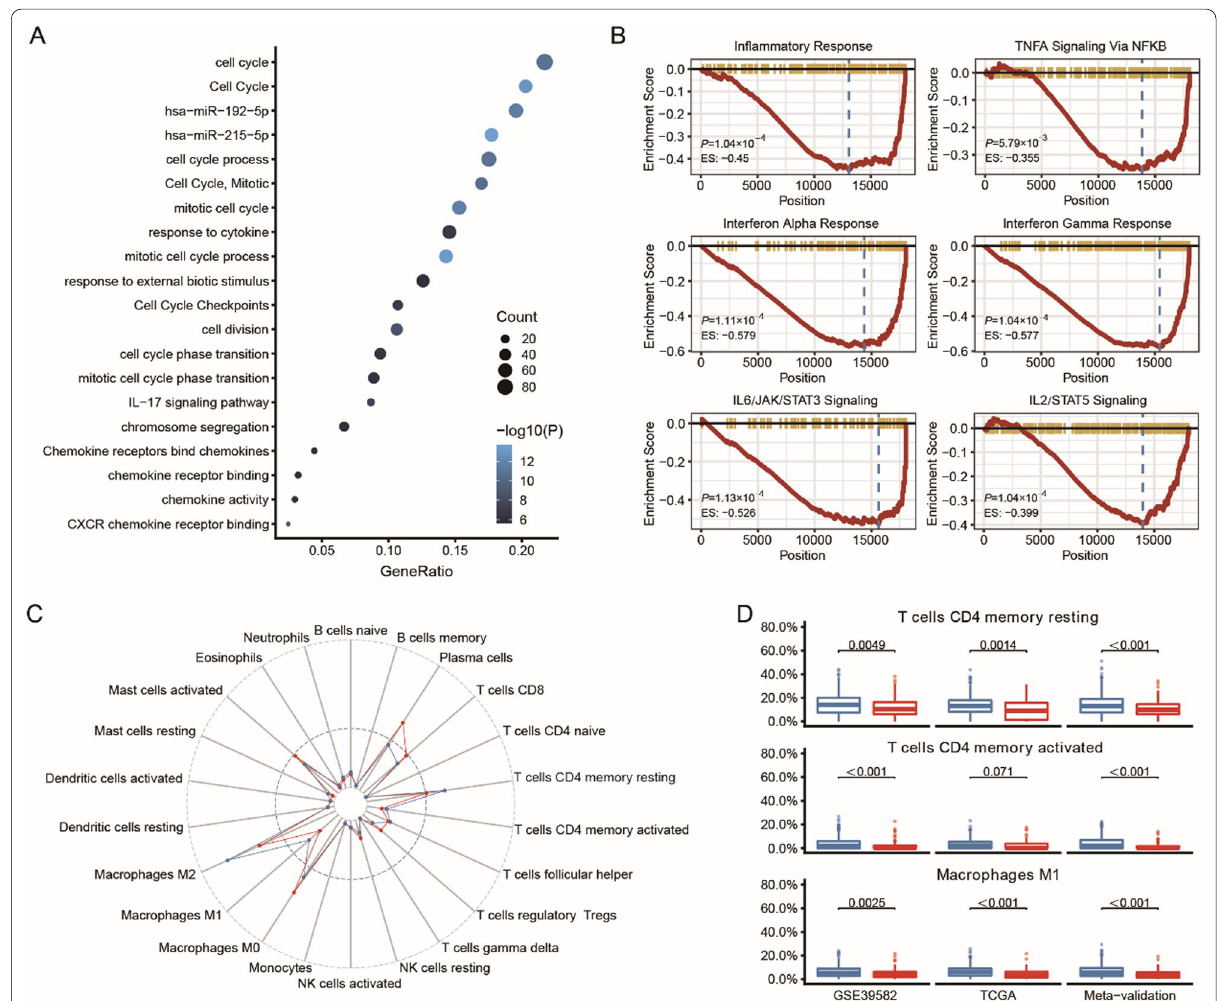
Fig. 4 Functional annotation of FRGS. A Enrichment analysis of the differentially expressed genes between different groups in GO. B GSEA analysis showed inflammatory response, TNF‑α, IFN‑α, IFN‑γ, IL‑6 and IL‑2 were depressed in high‑risk patients. C Infiltrations of immune cells are assessed based on TCGA cohort. D CD4 T cells and M1 macrophages were depressed in the high fibroblastic +